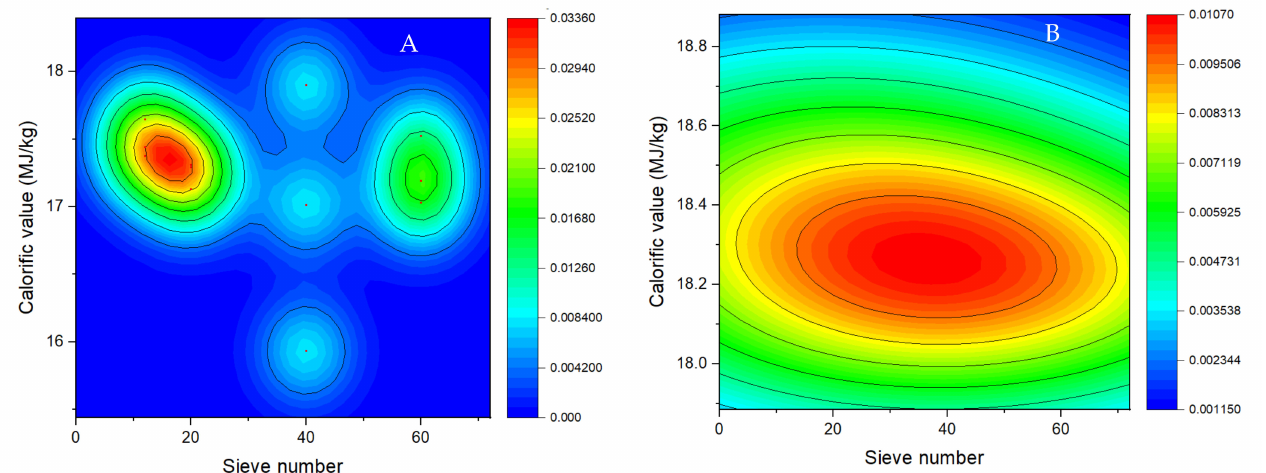
Figure 2. Calorific values of pecan pericarp residues at the different particle sizes 1.6 mm (N ◦ 12), 0.84 mm (N ◦ 20), 0.42 mm (N ◦ 40) and 0.25 mm (N ◦ 60). ( A ). Raw material; ( B ).